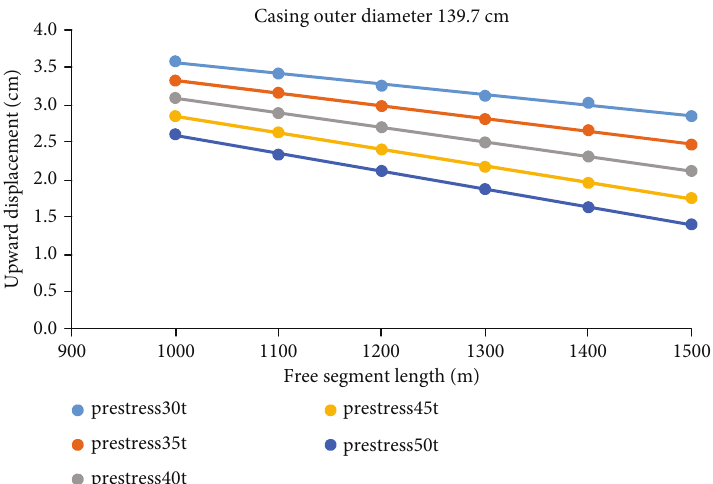
Figure 11: The relationship between the moving up amount and the length of the free segment under di ff erent prestresses of the two open wells (casing outer diameter